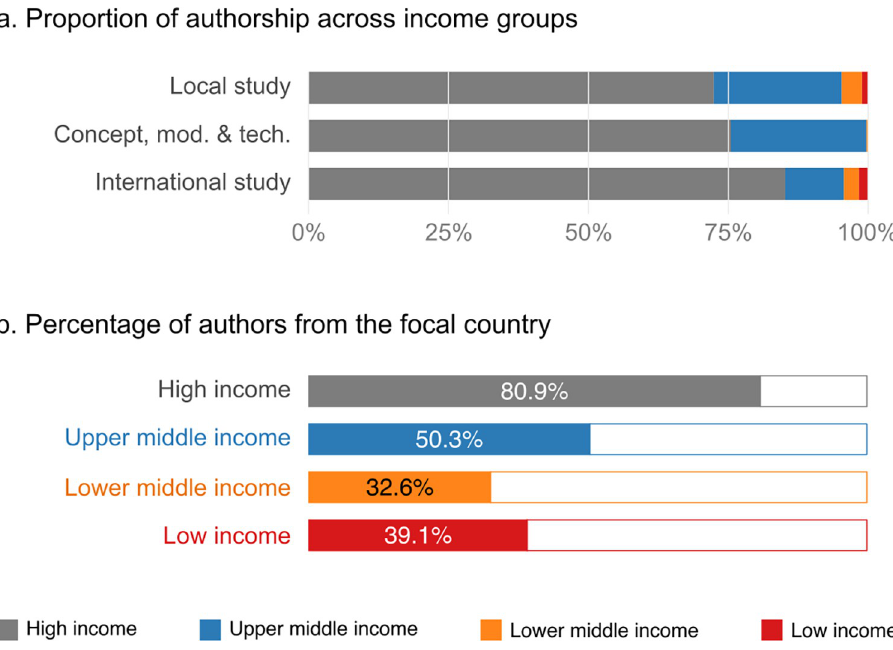
Fig 4. Origin of co-authors of sustainability science articles. a . Proportion of authorship across income groups for different types of publications in Nature Sustainability . b . Percentage of local authors among all co-authors involved in publications on a focal country (local